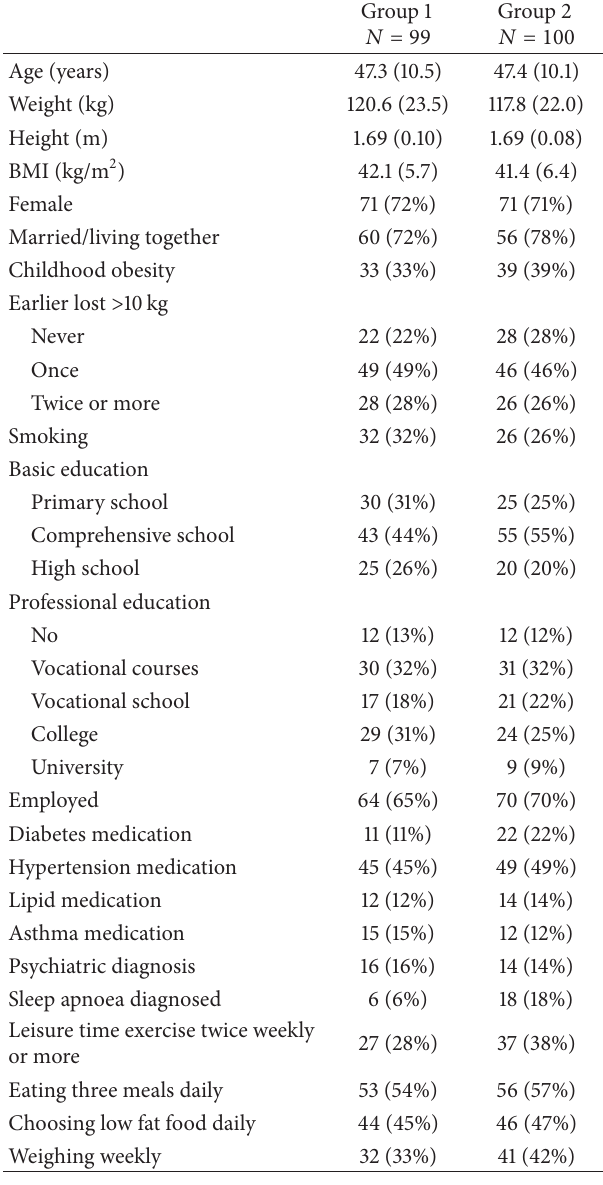
Table 1: Baseline demographic and clinical characteristics of the patients by treatment group, data are means (SD) or numbers (%).